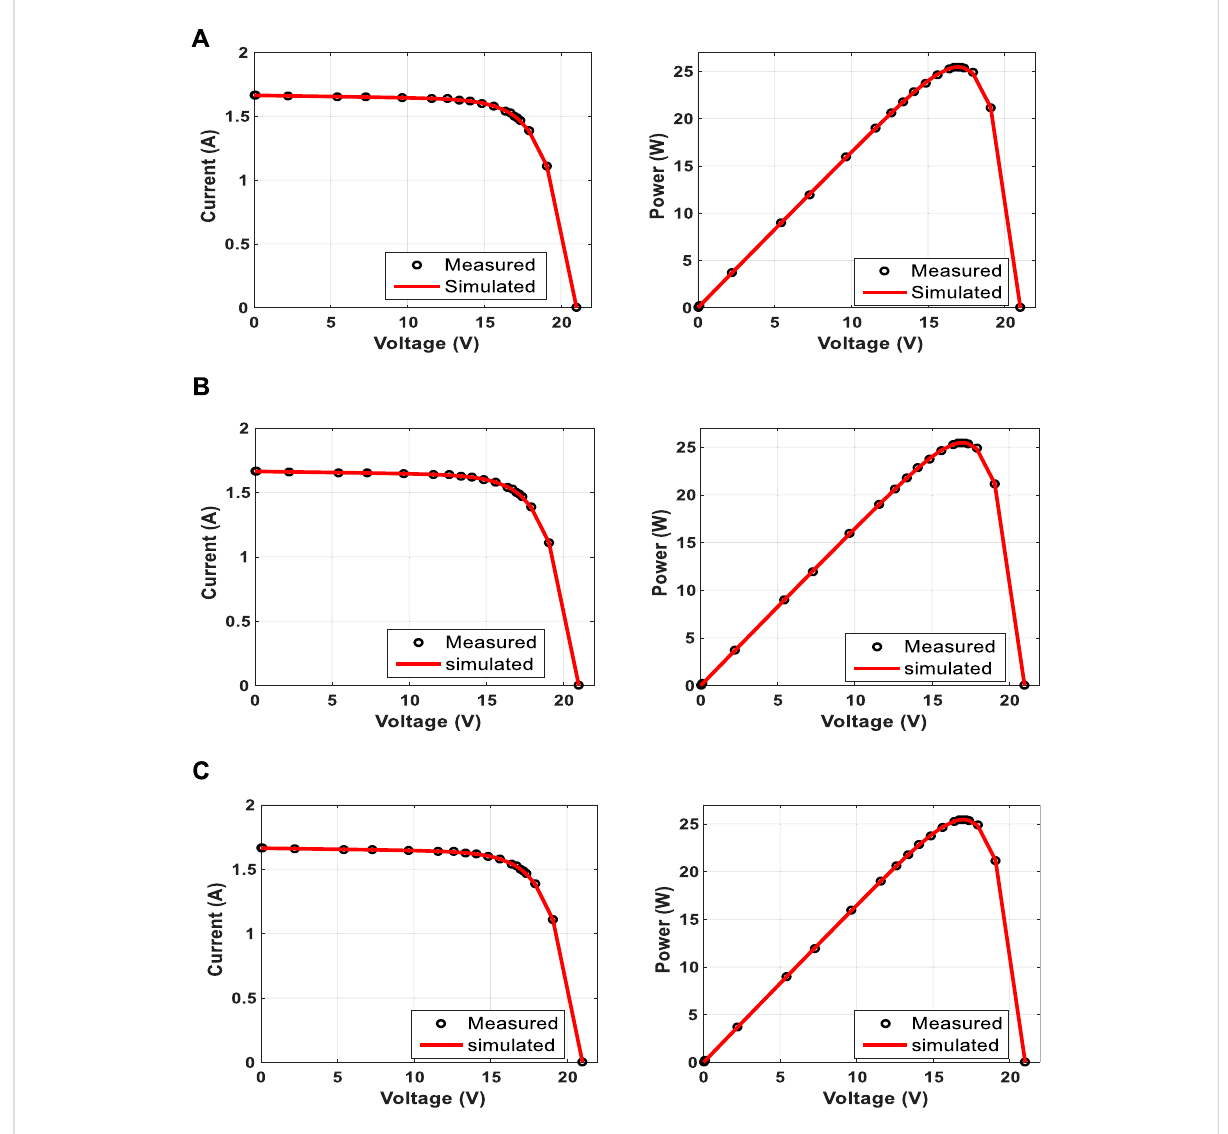
FIGURE 8 Measured and simulated I – V and P – V curves of the STM6-40/36 panel. (A) SDM, (B) DDM, and (C)